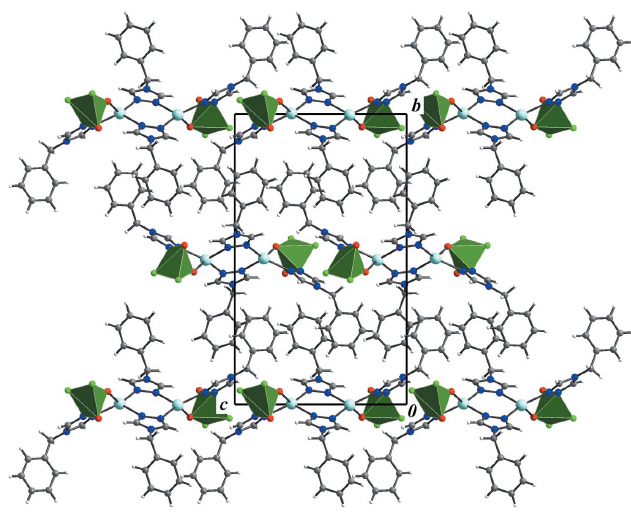
Figure 2 Projection on the bc plane showing the crystal packing of compound I .